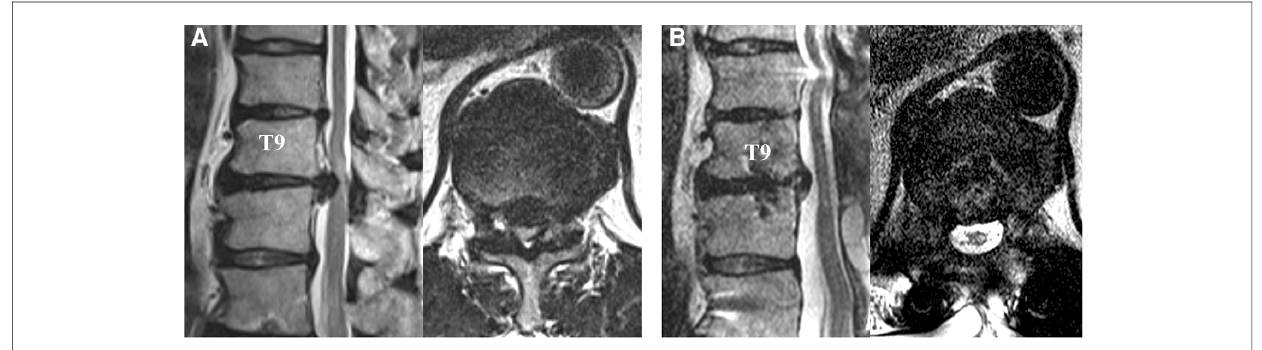
FIGURE 3 Pre- ( A ) and postoperative MRI ( B ) of the patient, a 45-year-old male, with ossi fi cation of the posterior longitudinal ligament (OPLL) at T9 – 10. ( A ) The spinal cord is severely compressed from anteriorly by OPLL at T9 – 10 with signi fi cant T2 high signal intensity. ( B ) After our modi fi ed Ohtsuka procedure, the spinal cord was completely decompressed, and cerebrospinal fl uid was con fi rmed at the ventral side of the spinal